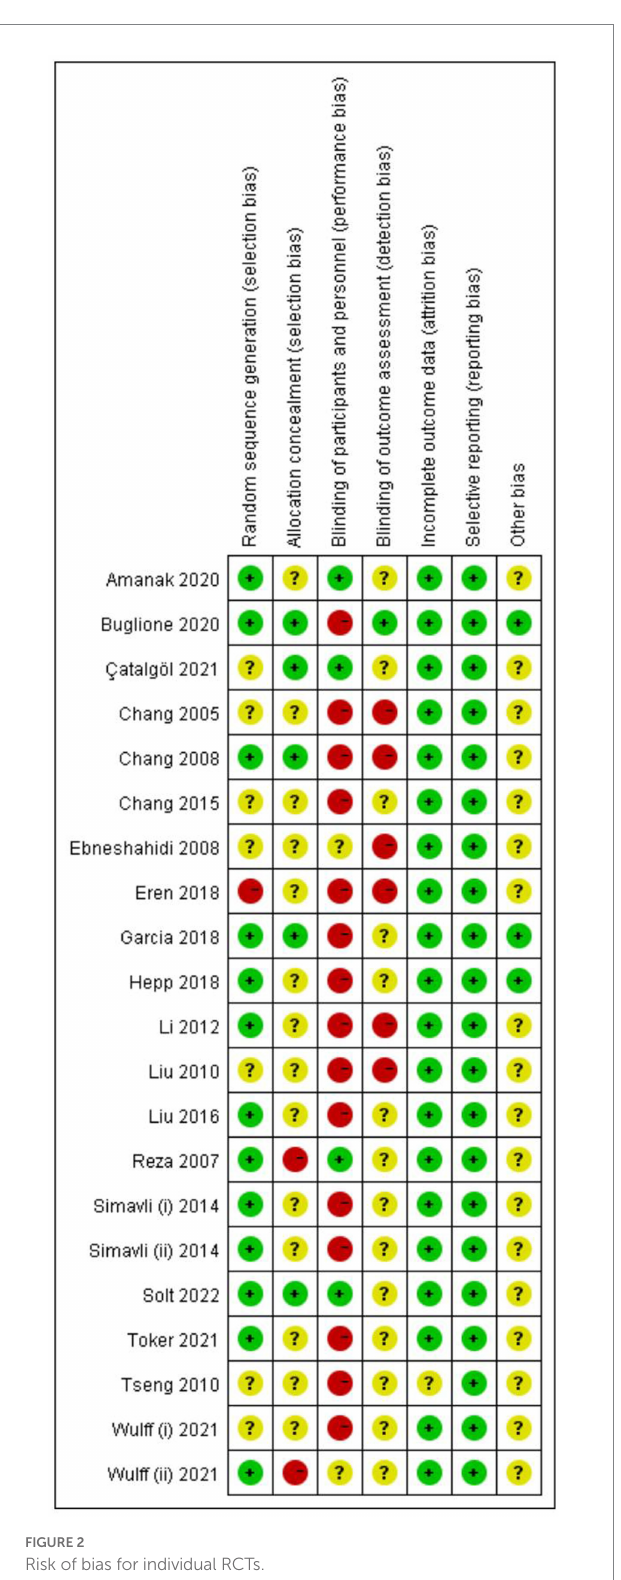
FIGURE 2 Risk of bias for individual